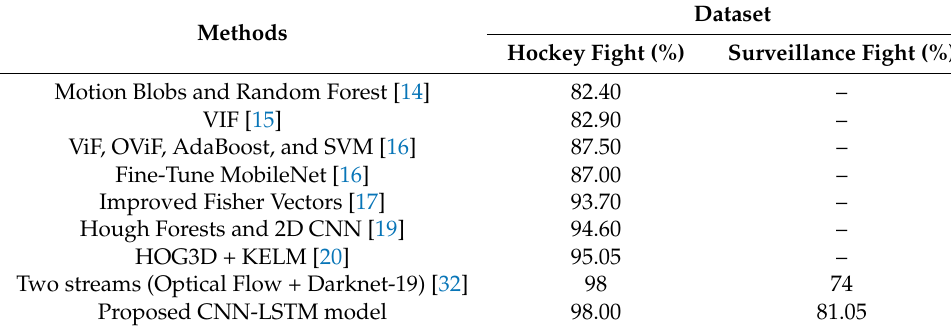
Table 15. Comparative analysis of the proposed model with existing